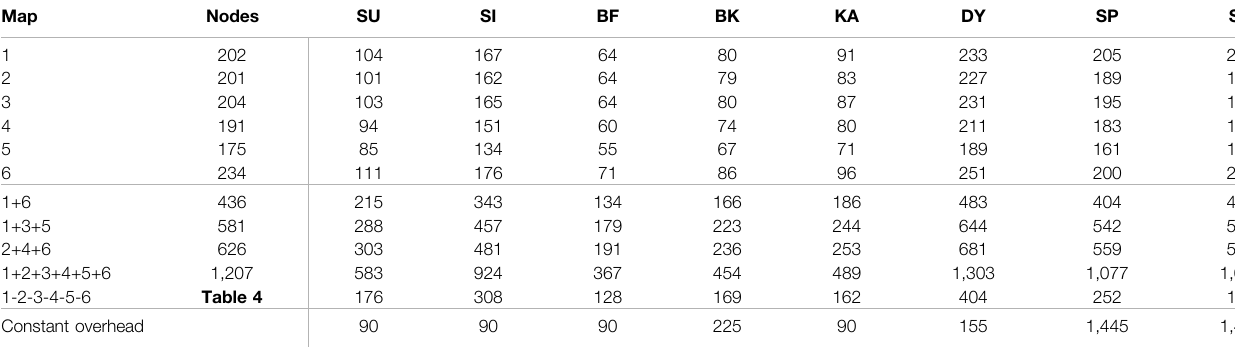
TABLE 3 | Graph size and RAM usage (MB) computed using Valgrind ’ s Massif tool of each map for each visual feature used. Map Nodes SU SI BF